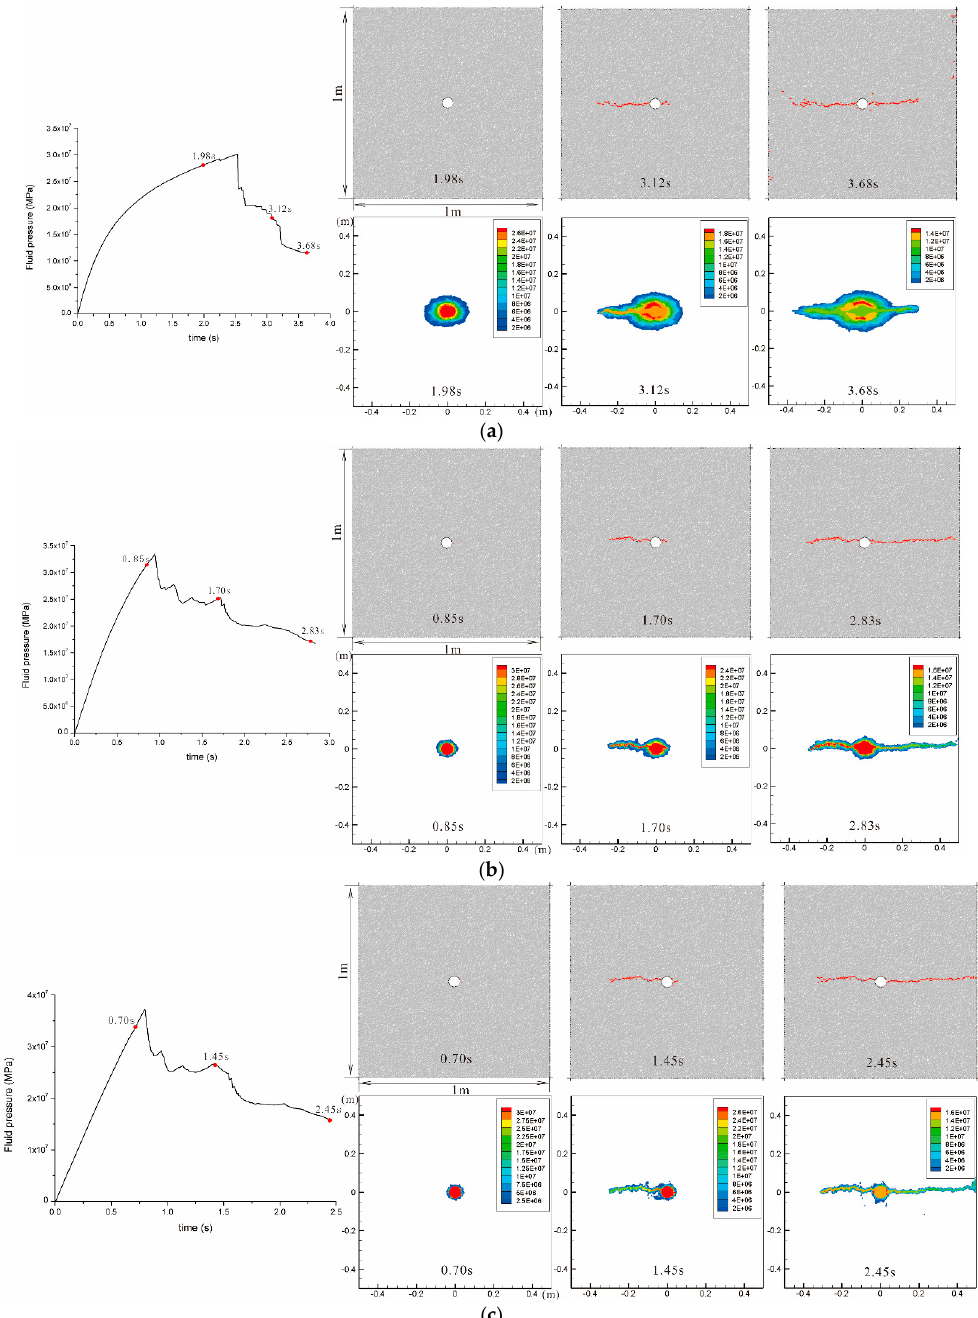
Figure 12. Borehole pressure histories and crack distribution with corresponding fluid pressure states in hydraulic fracturing with the injection rate of 1.0 × 10 − 5 m 3 /s and three different fluid viscosities: ( a ) 1.0 × 10 − 4 Pa · s; ( b ) 1.0 × 10 − 3 Pa · s; and ( c ) 1.0 × 10 − 2 Pa ·